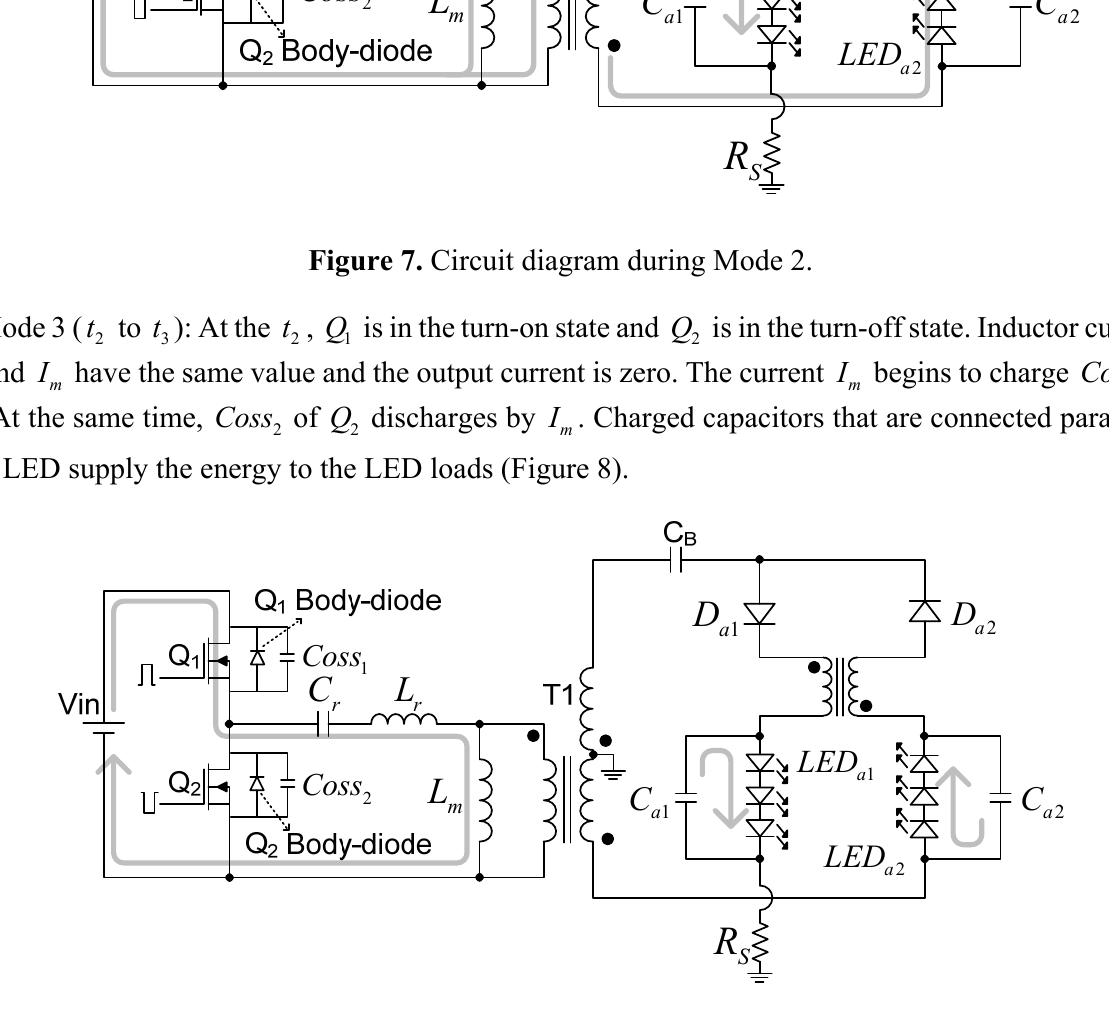
Figure 8. Circuit diagram during Mode